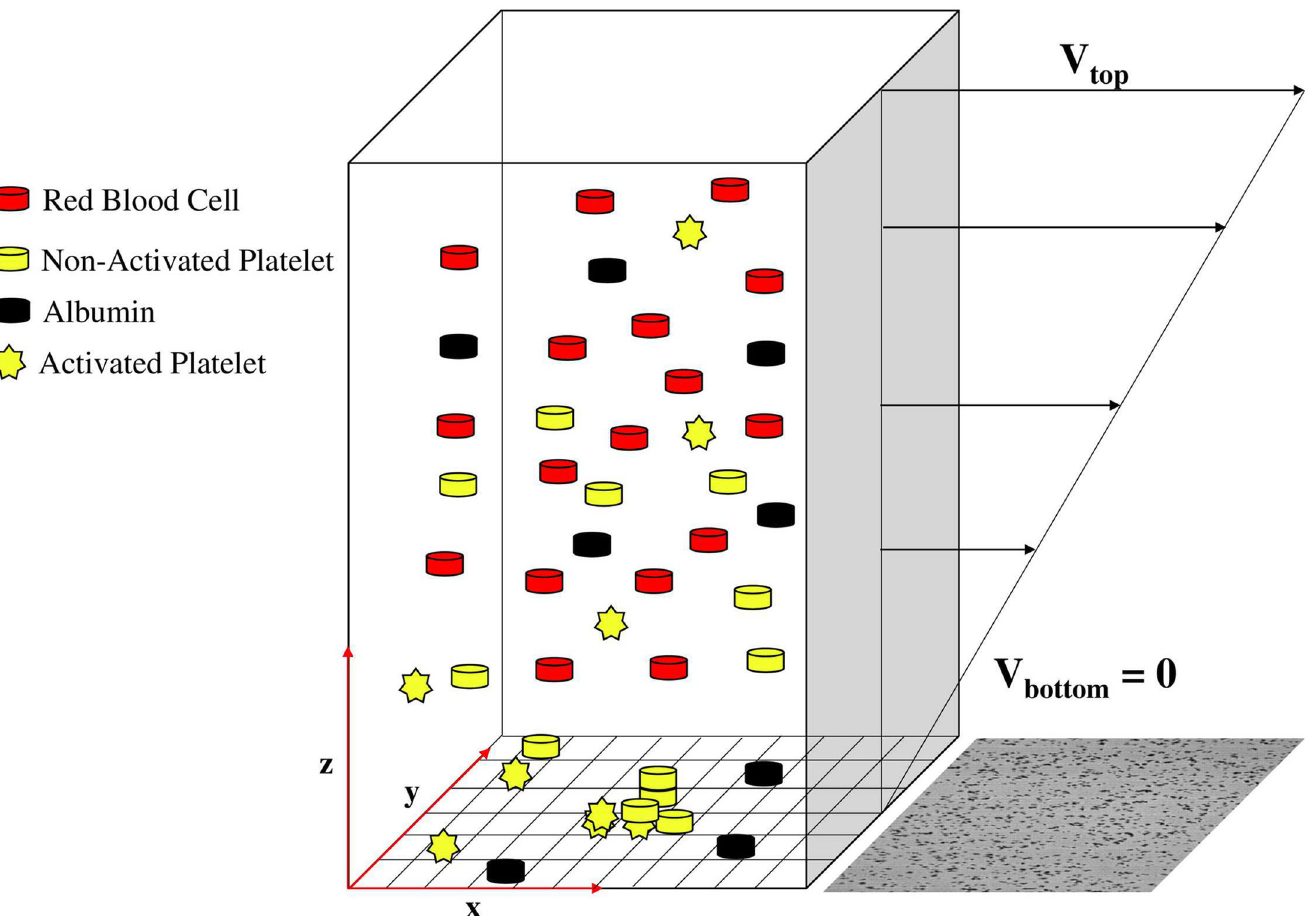
Fig 4. Window of Impact-R device. The bottom wall is a fixed boundary of dimensions 1 × 1 mm 2 , the wall-bounded direction is 0.82 mm . The bulk contains whole blood at different hematocrit. The discretization of the substrate is such that in every cell can fit just one platelet. The initial densities of the blood particles are determined by the in vitro experiment and usually are about: 172 200 ( μl ) − 1 for NAP, 4808 ( μl ) − 1 for AP, 2.69 × 10 13 ( μl ) − 1 for Al. The image next to the discretised substrate corresponds to the in vitro experiment.